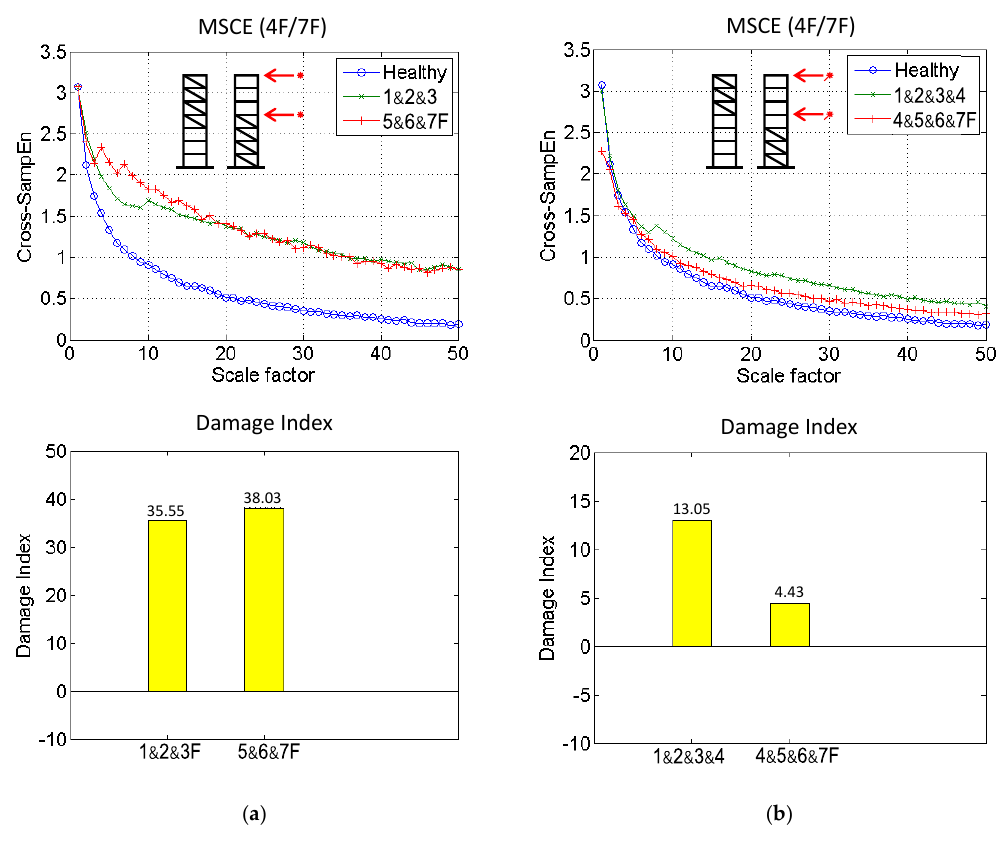
Figure 6. MSCE and DI diagrams of ( a ) three-story and ( b ) four-story damage.